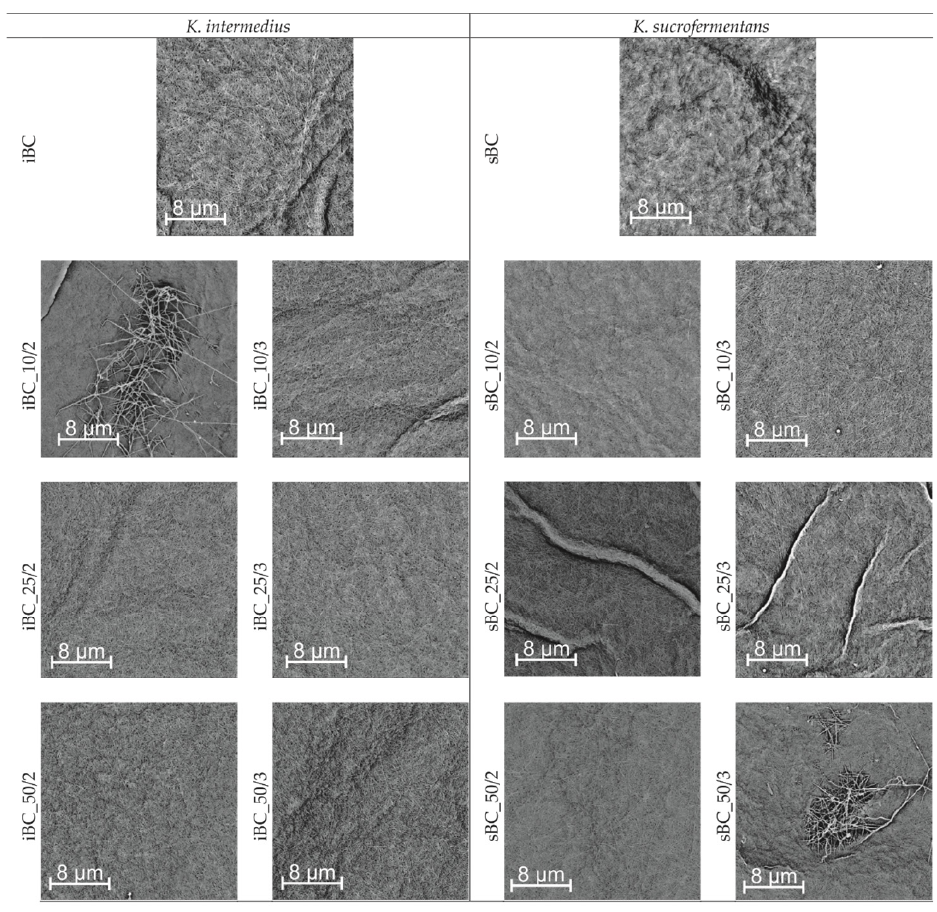
Figure 8. SEM microphotographs of all nanofiber membranes obtained using both bacterial strains. Magnification: 100,000 ×